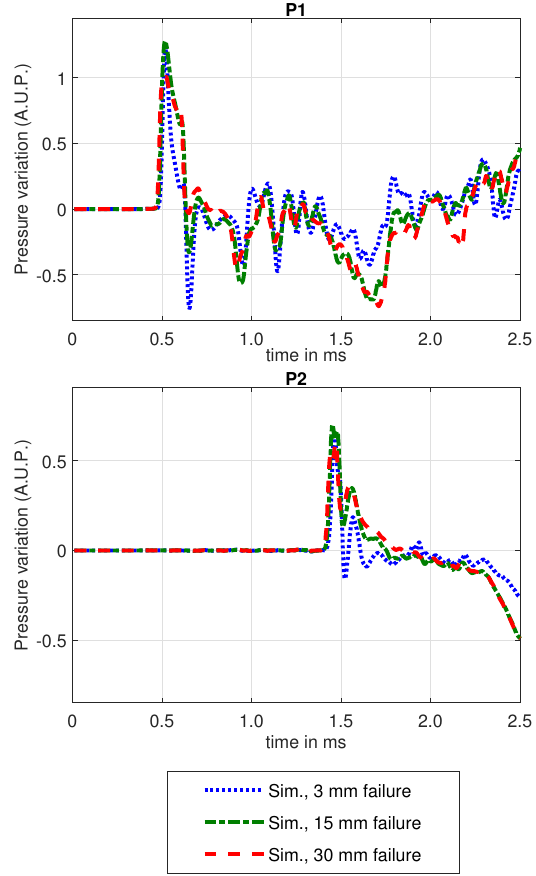
Figure 4. Simulated pressure at P1 and P2 for different simulated failure